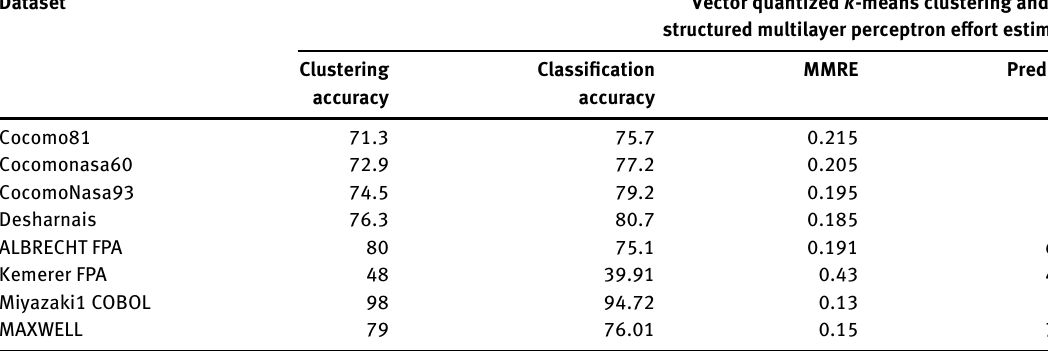
Table 3: Deep Structured Multilayer Perceptron Effort Estimation Using Vector Quantized k -Means Clusters. Dataset